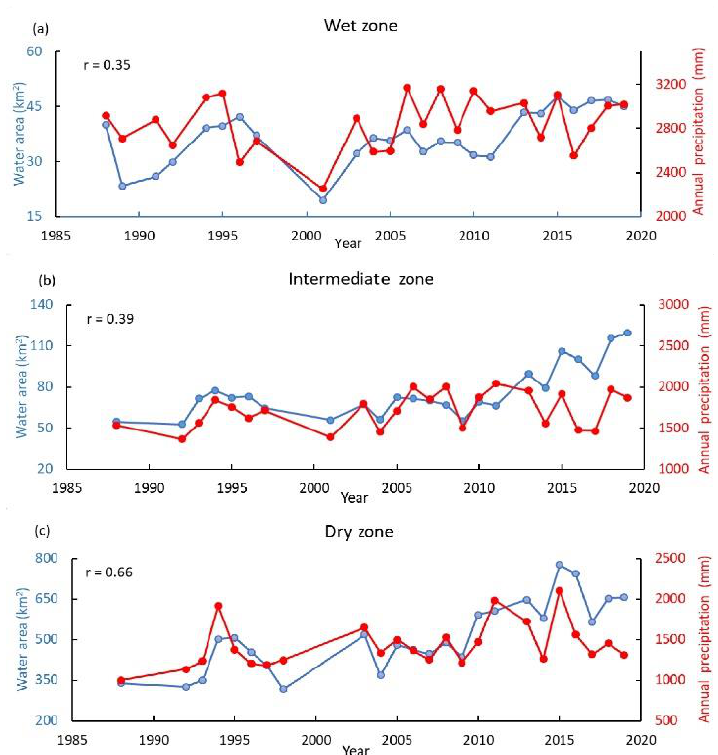
Figure 10. Time-series of annual surface water area and annual cumulative precipitation in different zones: ( a ) Wet zone, ( b ) Intermediate zone, and ( c ) Dry zone.